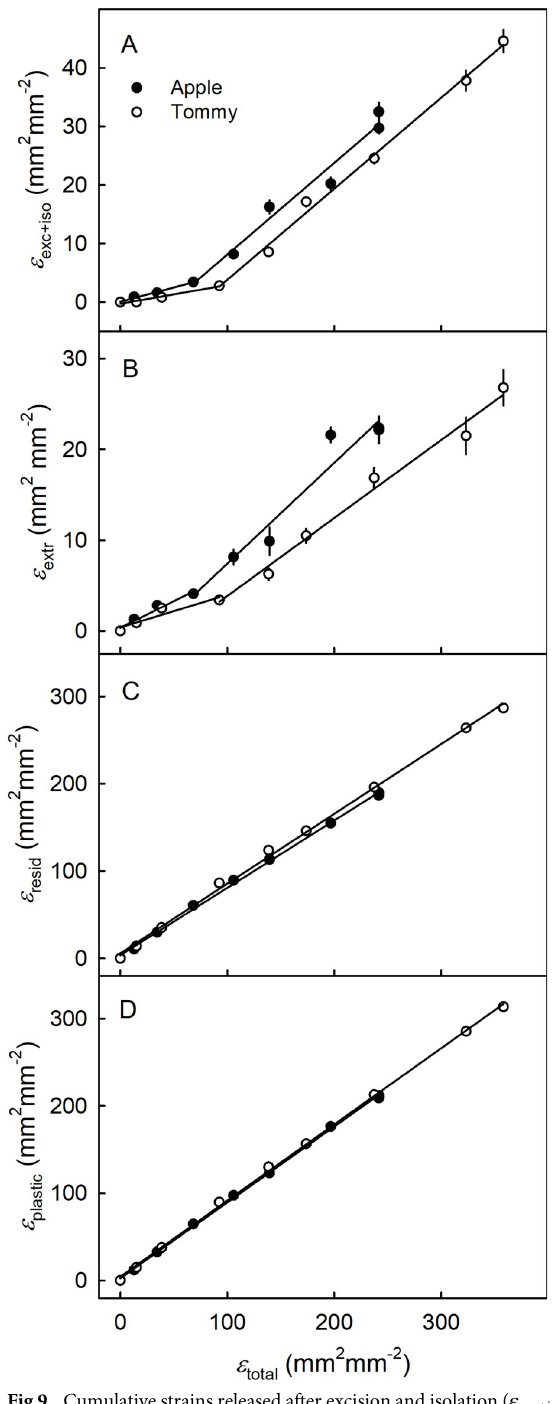
Fig 9. Cumulative strains released after excision and isolation ( ε exc+iso ) of the cuticular membrane (CM) (A), after wax extraction from the CM ( ε extr ) (B), the strain that remains in the dewaxed CM ( ε resid ) (C) and the sum of ε extr and ε resid ( ε plastic ) (D) plotted against the total cumulative strain ( ε total ) of the surface of developing ‘Apple’ and ‘Tommy Atkins’ mango. The ε total was estimated from the increase in surface area with time relative to the surface area at bloom. The ε resid was estimated as the difference between the total strain ( ε total ) and the strain due to the wax and tissue ( ε exc+iso+extr ). Data represent means ± SE. The number of replicates was 10–20.